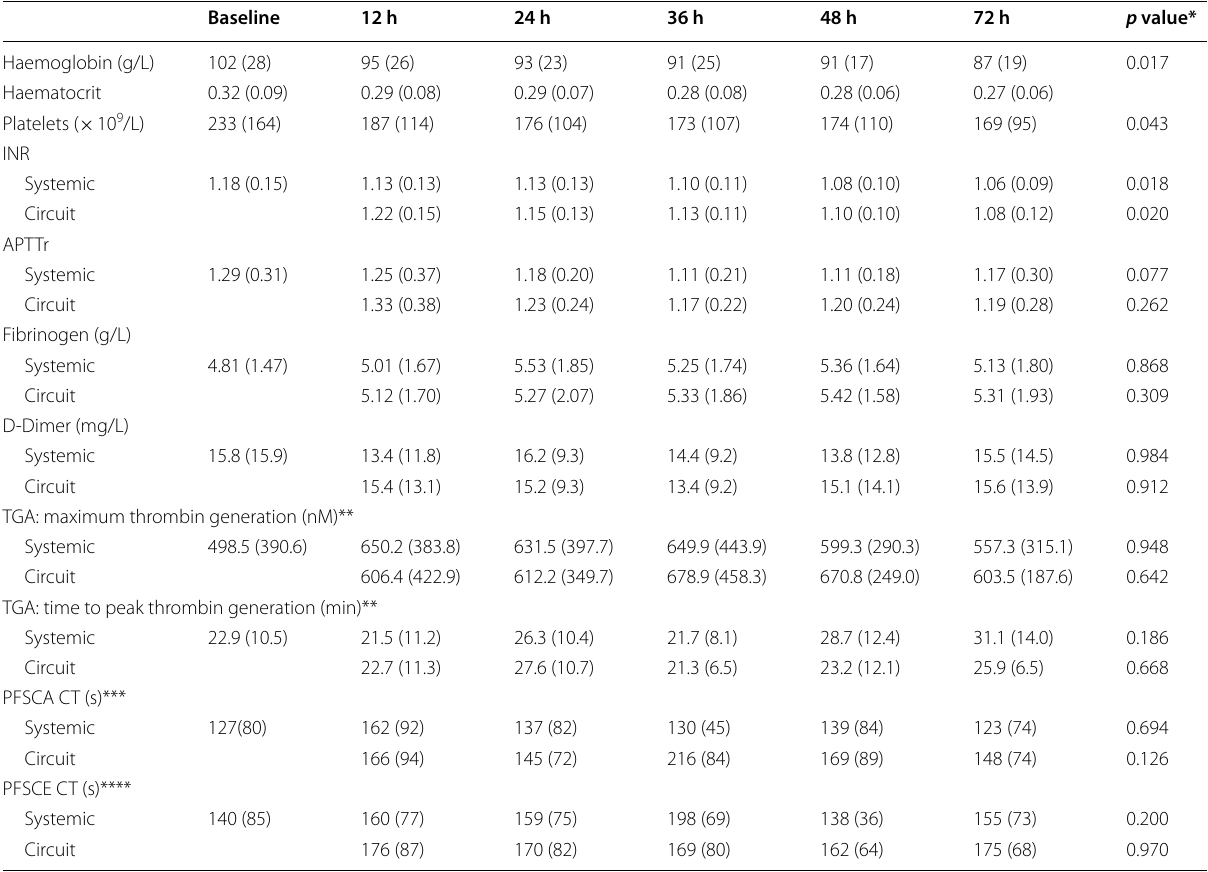
Table 3 Changes in measurements of coagulation over duration of